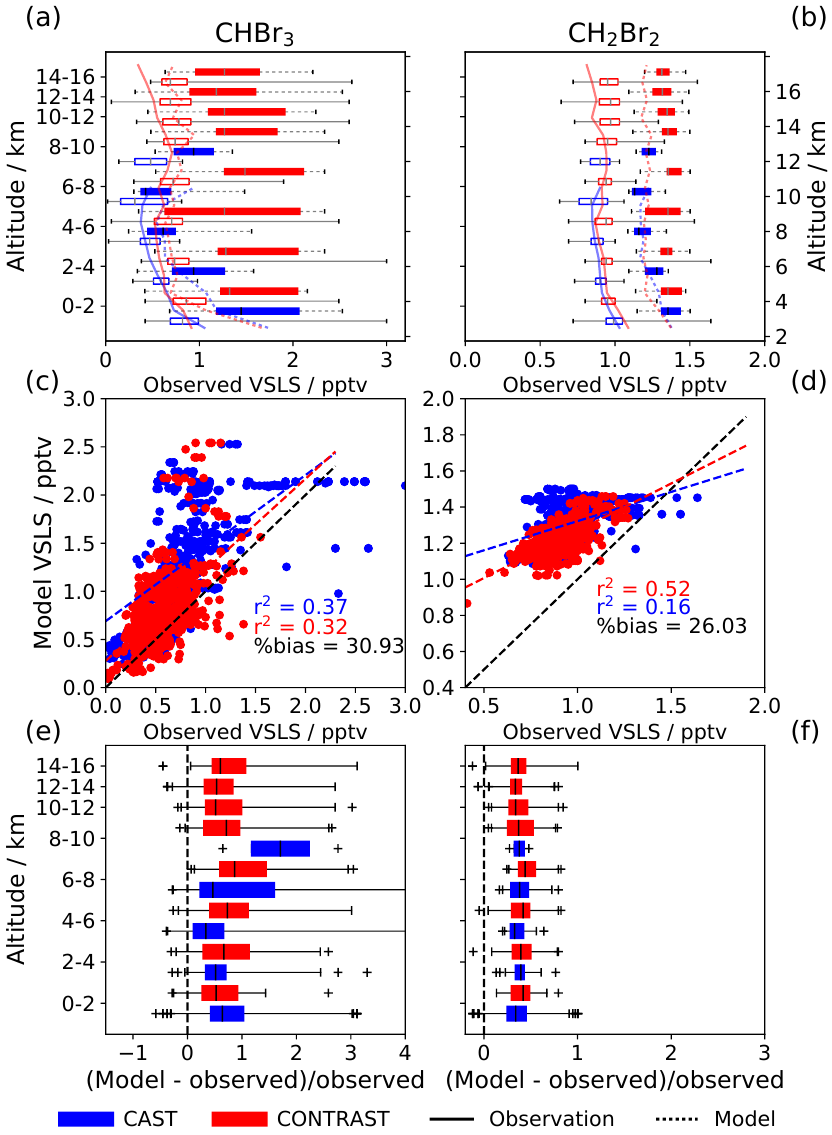
Figure 4. Comparison of model and observed (a, c, e) CHBr 3 (pptv) and (b, d, f) CH 2 Br 2 (pptv) mole fraction data for CAST (denoted by blue) and CONTRAST (denoted by red). Panels (a, b) describe the comparison between model (dotted line) and observed (solid line) values as a box-and-whiskers plot on 2km altitude bins. Panels (c, d) describe the model and data comparison as a scatter plot. Pearson correlations ( r 2 ) and percentage biases are shown inset. Black, red, and blue dashed lines denote the 1:1 line, and the best fit linear models for CONTRAST and CAST, respectively. Panels (e, f) show the relative model error, described as a box-and-whiskers plot on 2km altitude bins. The vertical dashed line denotes the zero error